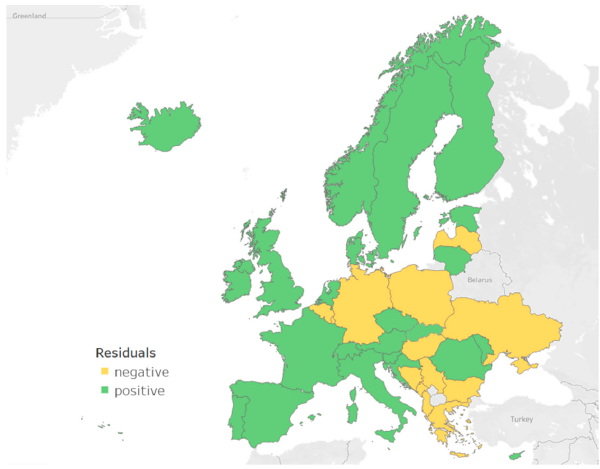
Energies 2021 , 14 , x FOR PEER REVIEW Figure 11. Moran’s I distribution for residuals for the ETI OLS model in Europe.